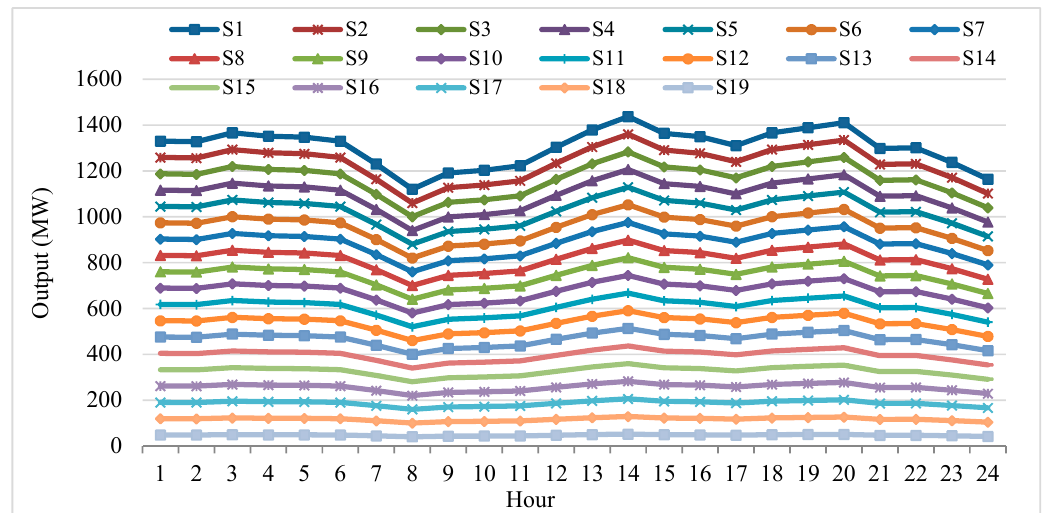
Figure 6. Output profile of the wind system according to the VGR mix scenarios.